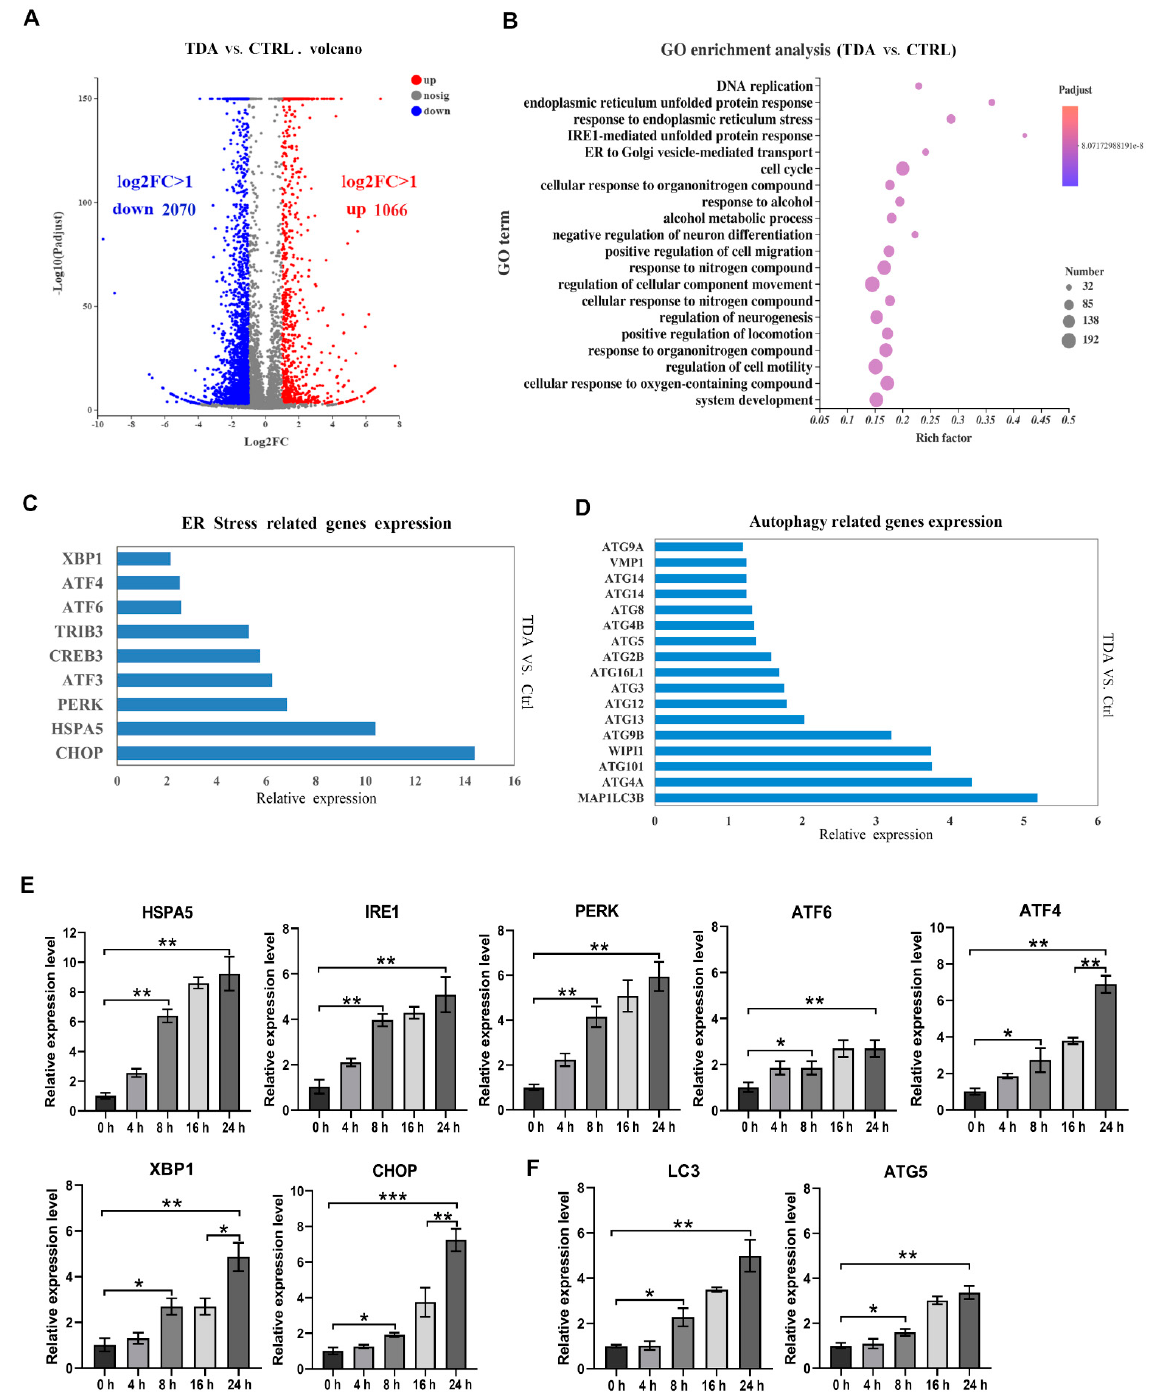
Figure 3. Transcriptome analysis of TDA-treated HCT116 cells. ( A ) The number of upregulated and downregulated differentially expressed genes in the transcriptome upon TDA (4 µ g/mL) for 24 h treatment is shown in the volcano map. ( B ) GO enrichment analysis of the signaling pathways of differentially expressed genes in the transcriptome. ( C ) The relative expression of genes related to ER stress pathway in transcriptome analysis was shown. ( D ) The relative expression of autophagy related genes in transcriptome analysis was shown. ( E , F ) The mRNA level of ER stress related genes ( E ) and autophagy related genes ( F ) were determined by real-time quantitative PCR after treatment with 6 µ g/mL TDA for indicated time. Data are presented as the mean ± SD from three separate experiments. * p < 0.05; ** p < 0.01; *** p <